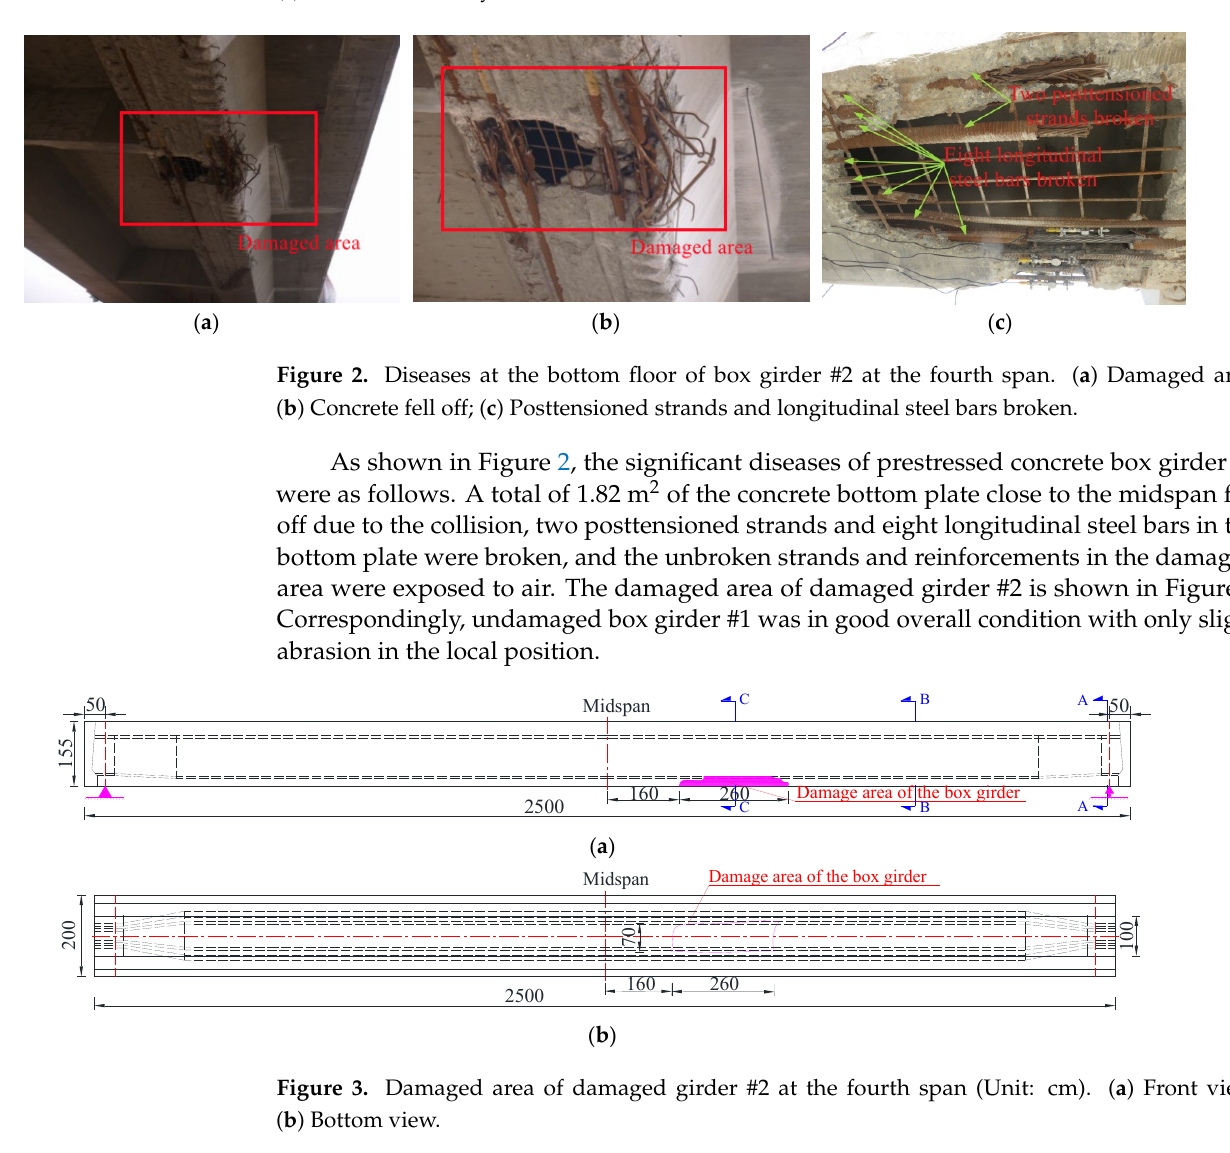
( b ) Figure 4. Cutting diagram of the box girder at the fourth span (Unit: cm). ( a ) A-A section; ( b ) B-B section. The arrangement of strands and steel bars in the box girder is shown in Figure 5, and the strength parameters of the concrete, strands and steel bars are shown in Table 1.